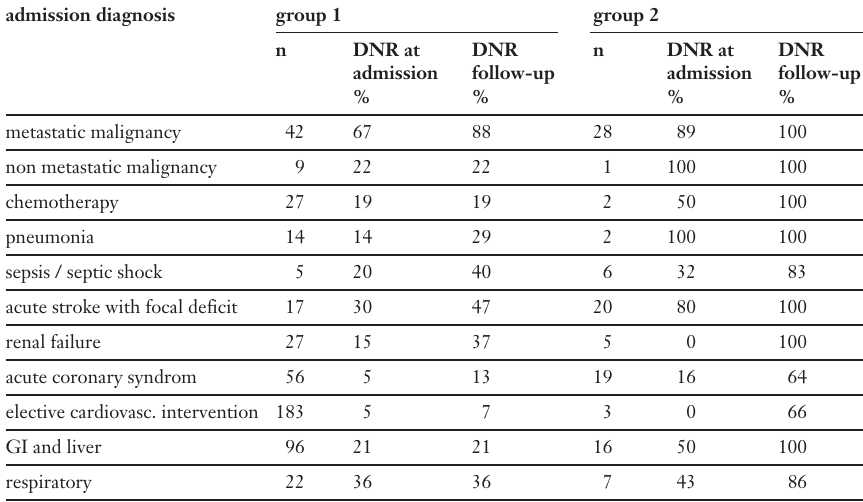
DNR on admission and during follow-up in the different diag- nostic